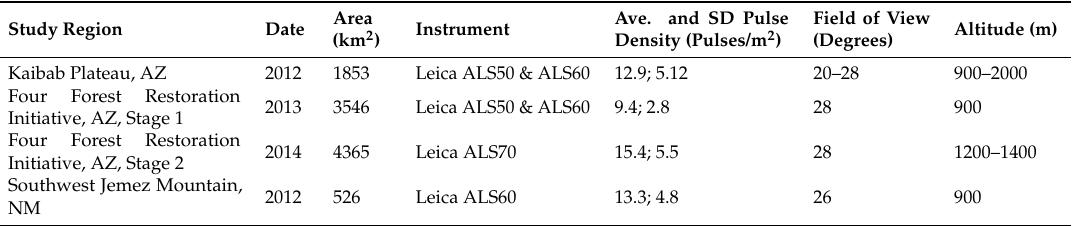
Table 2. Summary of the lidar specifications for each site. The average and standard deviation pulse density is